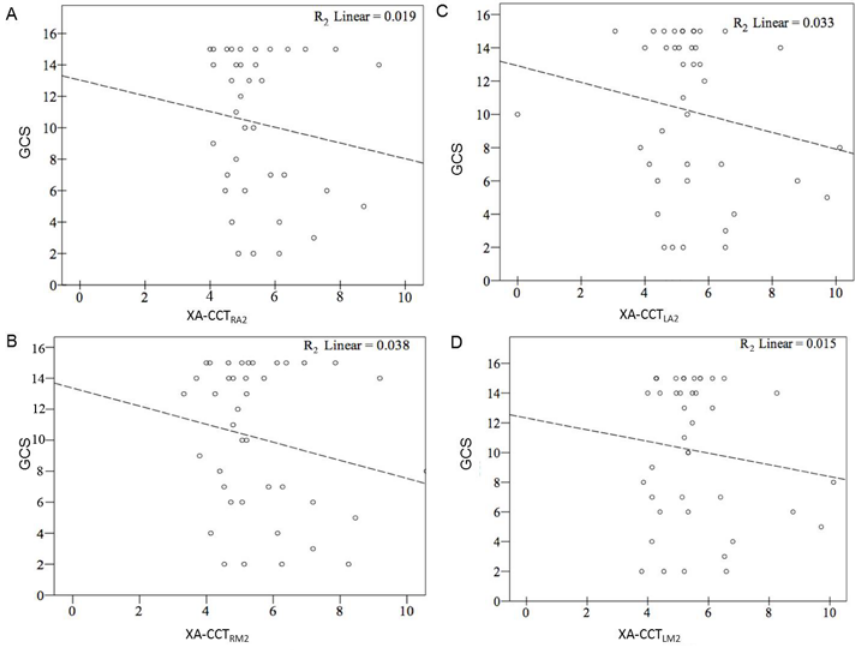
Fig 4. Correlation between GCS and four individual XA-CCTs. (A) XA-CCT RA2, (B) XA-CCT RM2, (C) XA-CCT LA2, and (D) XA-CCT LM2. GCS: Glascow Coma Scale, XA-CCT: Cerebral circulation time defined by digital subtraction angiography. The subscripted abbreviations following XA-CCT show different arterial ROIs used to calculate circulation time. RA2: the second segment of the right anterior cerebral artery; RM2: insular branch of the right-middle cerebral artery; LA2: second segment of the left anterior cerebral artery; LM2: insular branch of left-middle cerebral